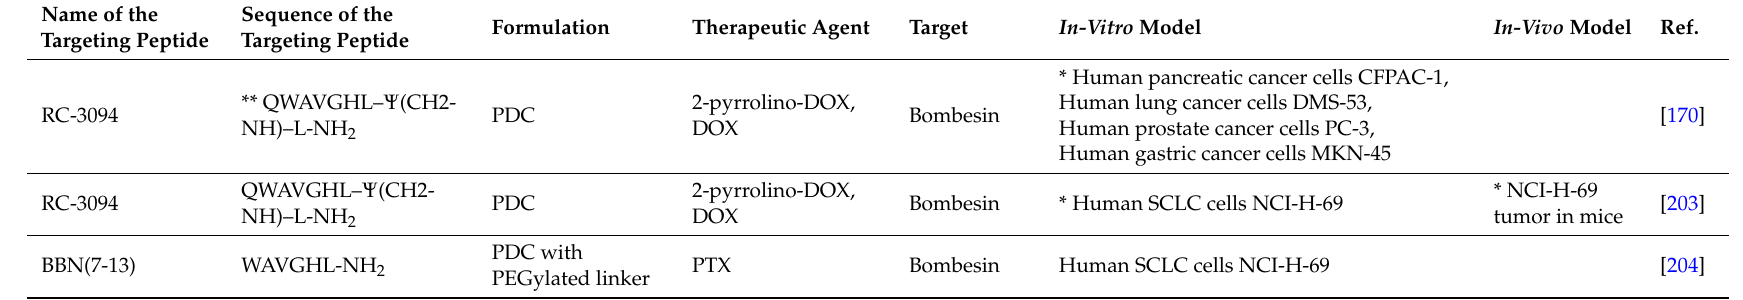
Table 4. Bombesin (BN) cytotoxic analogs. * For additional biological models of these conjugates see [2,186]. ** For additional BN analogs with 2-pyrrolino-DOX and DOX tested in the same biological models see [170].